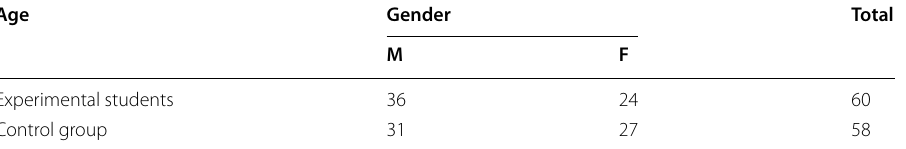
Table 1 Students’ demographic